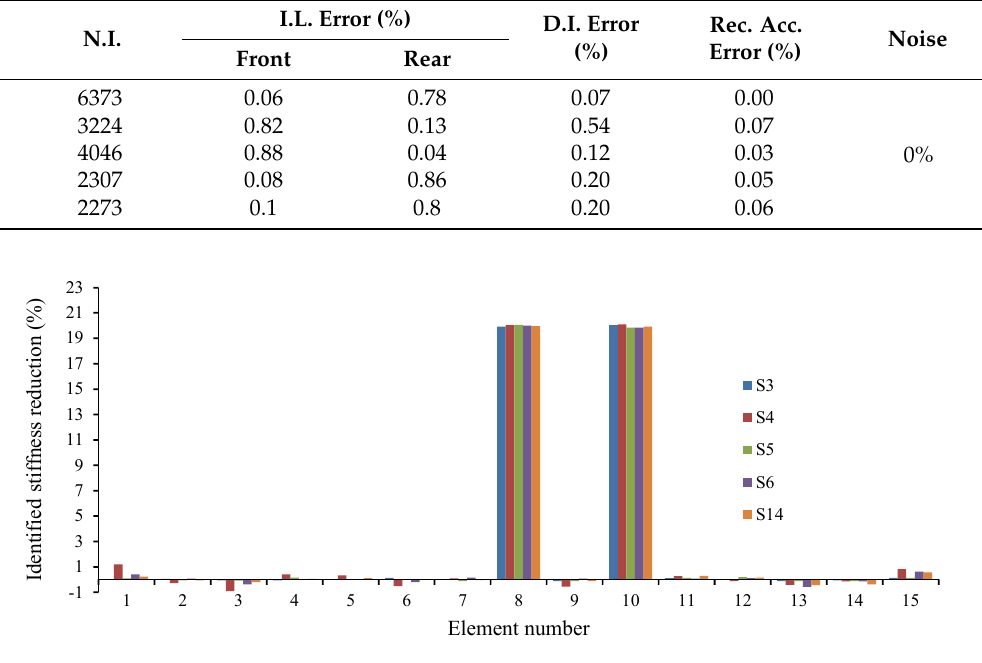
Figure 2. Effect of different sensor placements on identifying damage. Table 5. Different sensor placements configuration.